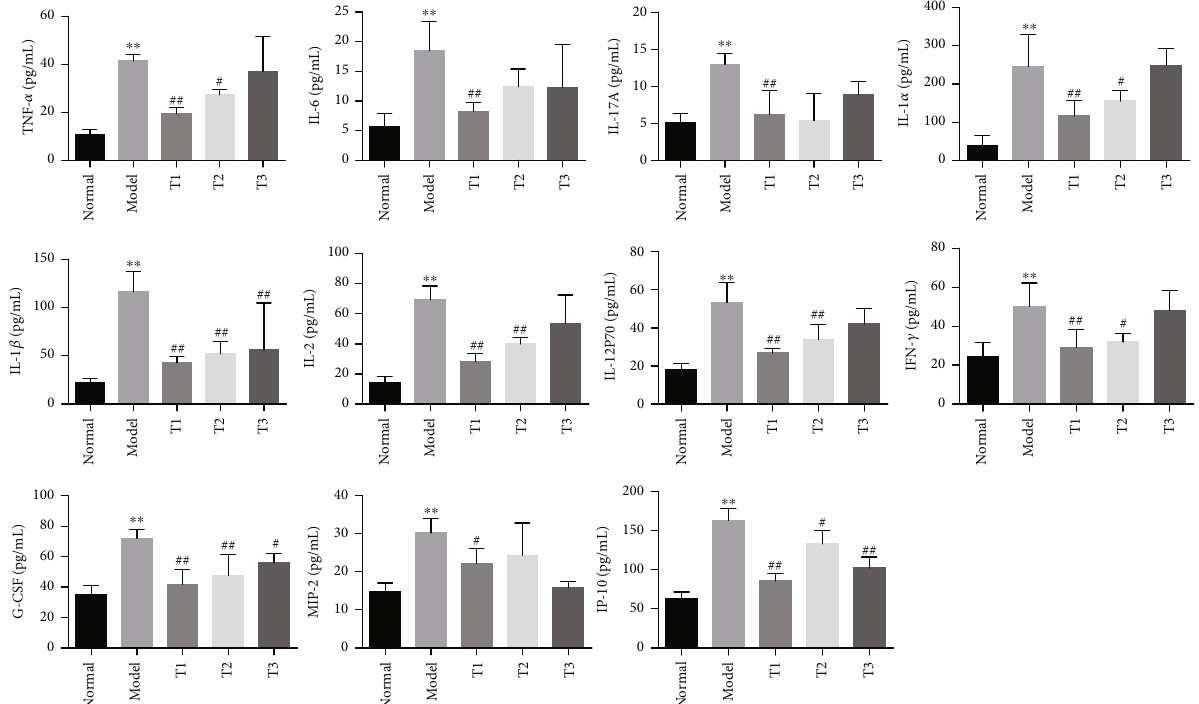
Figure 3: WB downregulated the serum levels of cytokines/chemokines in CIA rats. Multifactor detection of TNF- α , IL-6, IL-17A, IL-1 α , IL- 1 β , IL-2, IL-12P70, IFN- γ , G-CSF, MIP-2, and IP-10 in serum of rats from di ff erent groups. Data are mean ± SD , n = 6 . ∗∗ P < 0 : 01 compared with the normal group; ## P < 0 : 01 and # P < 0 : 05 compared with the model